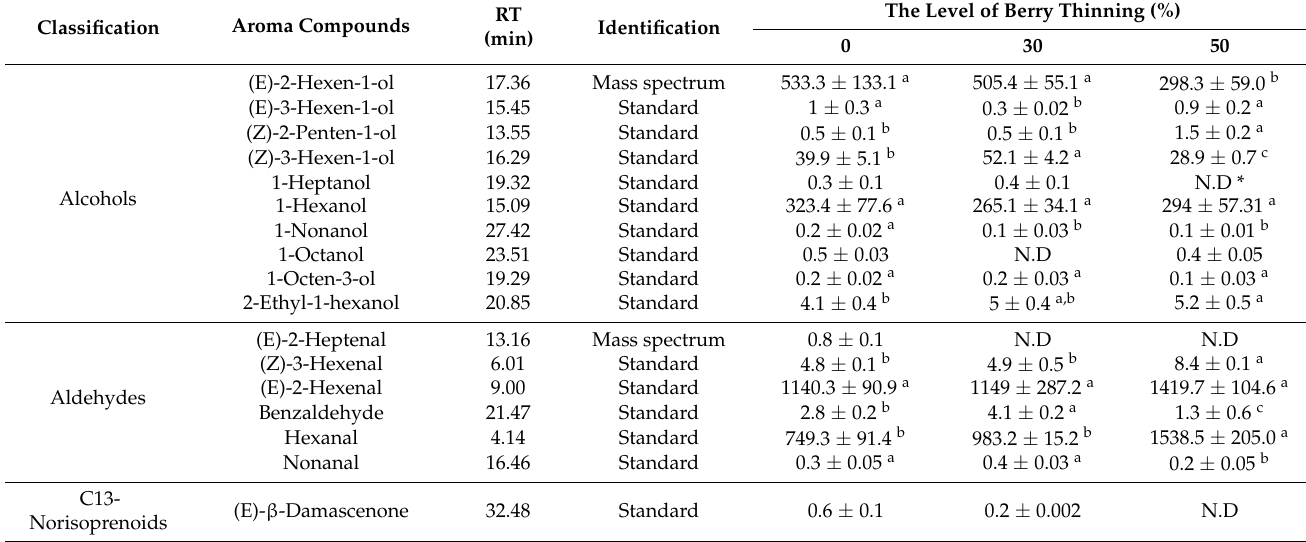
Table 2. Effects of berry thinning on the composition and concentration of volatile free aroma compounds in Shine Muscat grape juices.